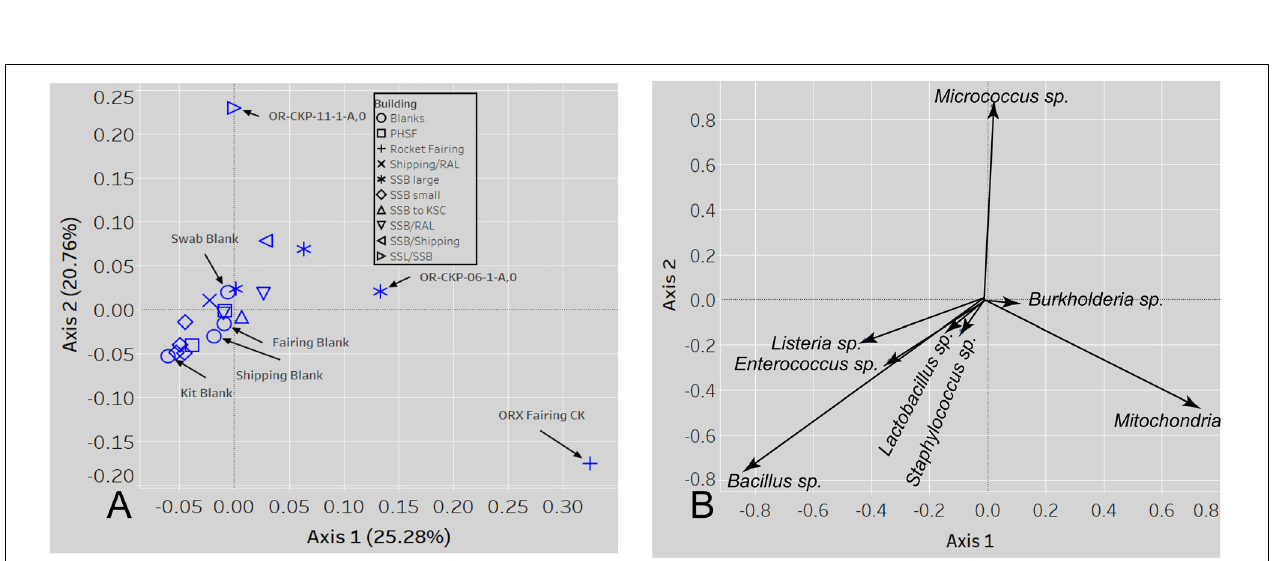
FIGURE 8 | A PCOA plot of the weighted UNIFRAC beta diversity metric (A) shows that samples 11 and the fairing CK sample are outliers. Samples are colored by location A biplot (B) shows which sOTUs/organisms affect the distribution of the data. The length of the arrow is proportional to the strength of the effect.